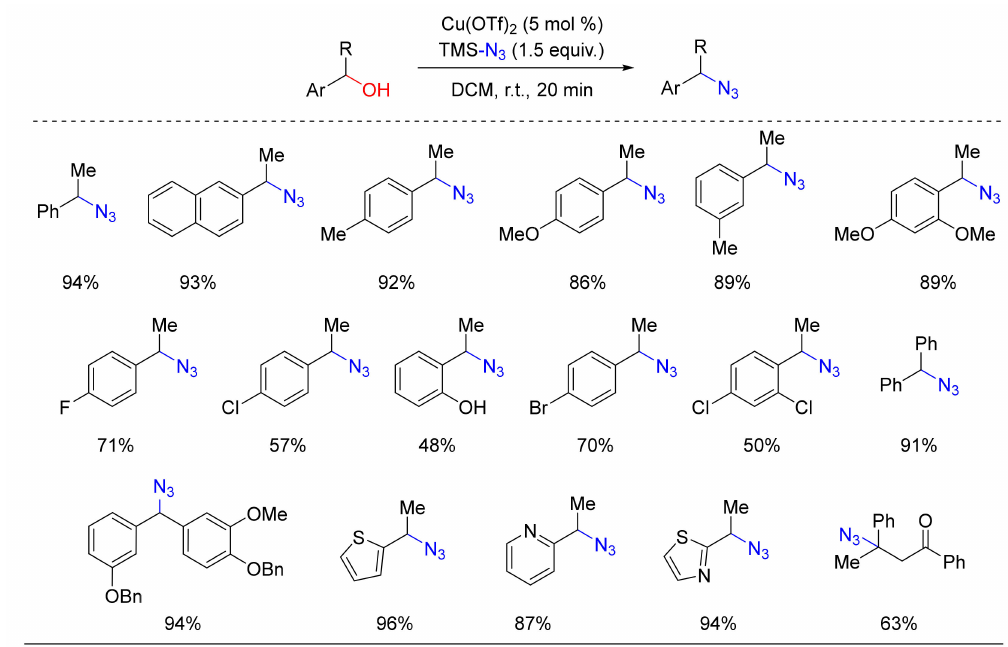
Scheme 10. Copper catalyzed conversion of benzyl alcohols into the corresponding azides.